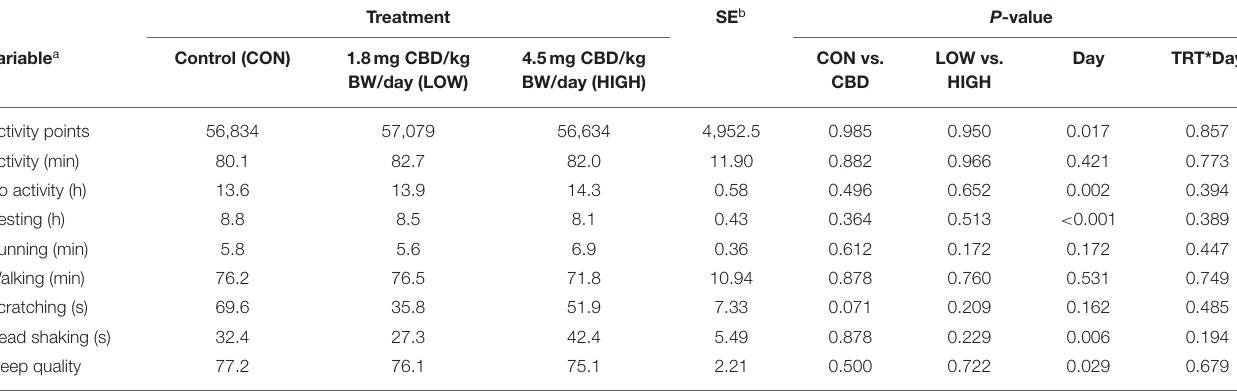
TABLE 3 | Effect of treatment (TRT), day, and TRT * day interaction on total daily activity variables collected via Vetrax ® activity sensors (AgLogica Technology, Norcross, GA). Treatment SE b P -value